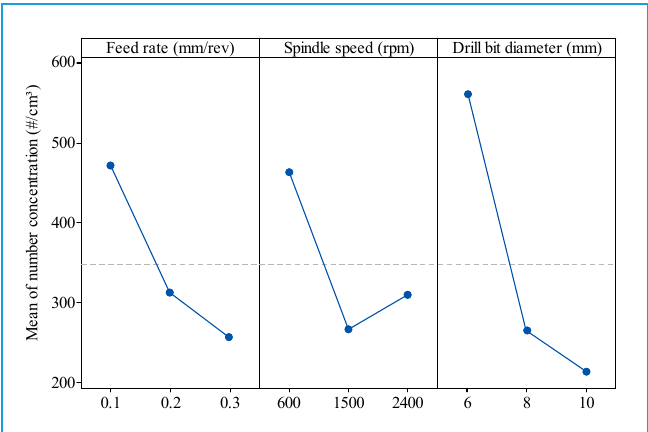
Figure 18. Main e ff ect plot for fine particles Figure 18. Main effect plot for fine particles emission.